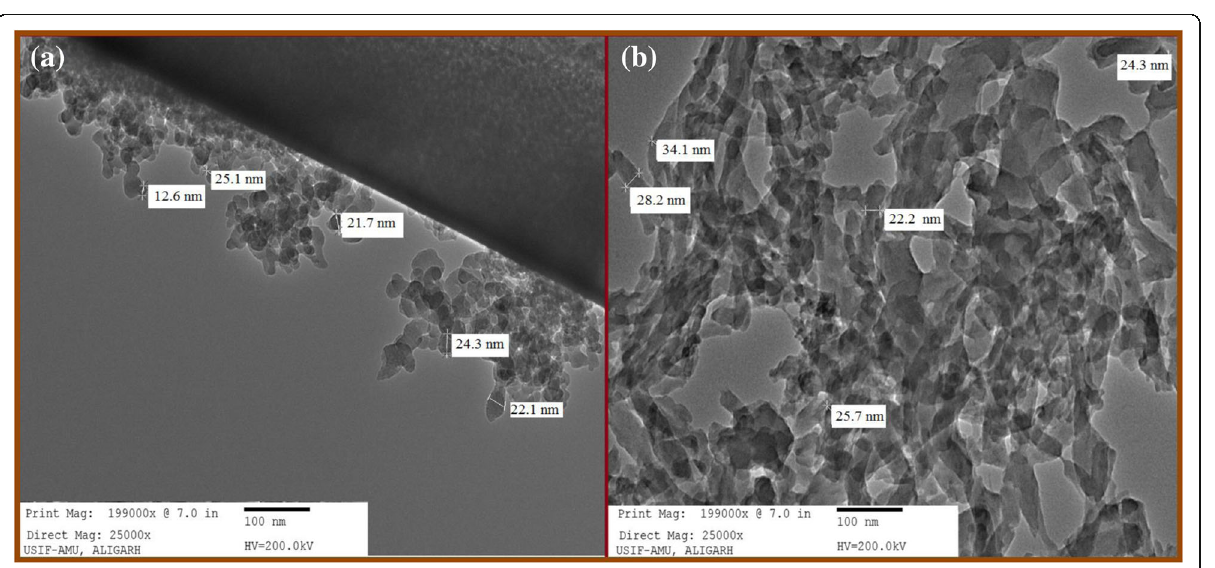
Fig. 5 TEM micrographs of a silica gel (S 1 ) and b Pani@SG (ES)-S 2